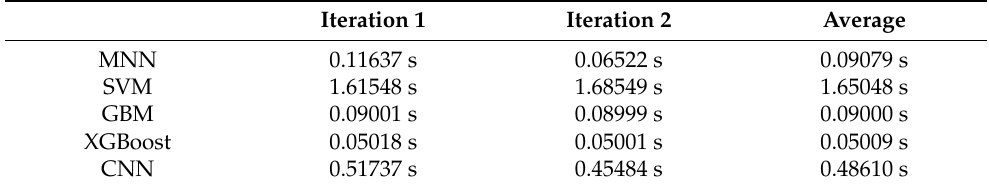
Table 13. Computation time for test data during cross-validation of SVM, MNN, CNN, GBM, and XGBoost models.